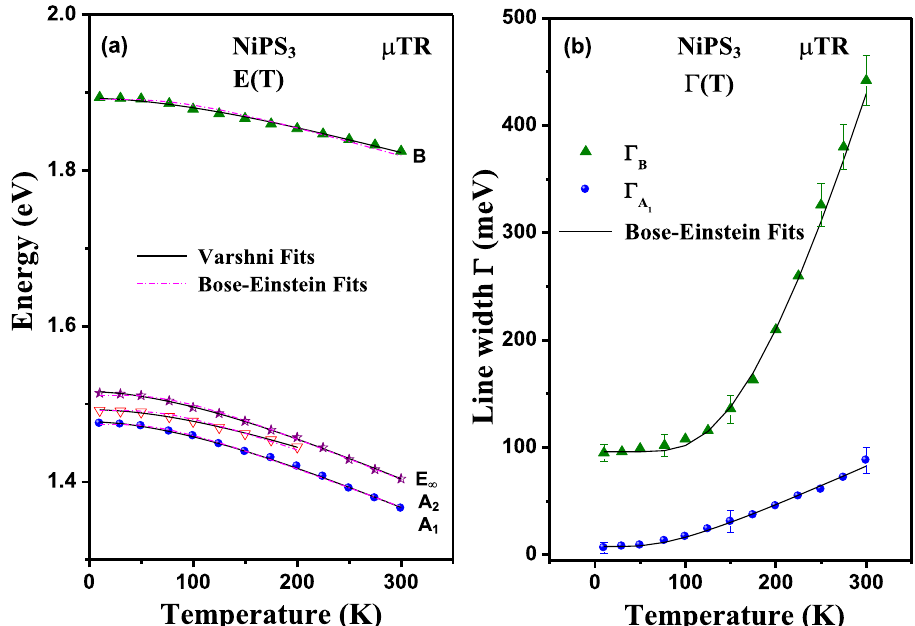
Fig. 3 Temperature dependence energies and broadening parameters of the A series and B features obtained by μ TR. a Temperature- dependent transition energies of the A series and B features obtained by μ TR measurements. The symbols are the data points, solid lines are the least-square fi ts of the Varshni type, and dashed lines are those of the Bose – Einstein fi tting. b Temperature dependence of the line-width broadening parameter of the A 1 and B features obtained by μ TR Fig. 2a, b. The energy values are A 1 = 1.475 eV, A 2 = 1.495 eV, E ∞ = 1.511 eV, and B = 1.894 eV, respectively. As shown in Fig. 2a, with